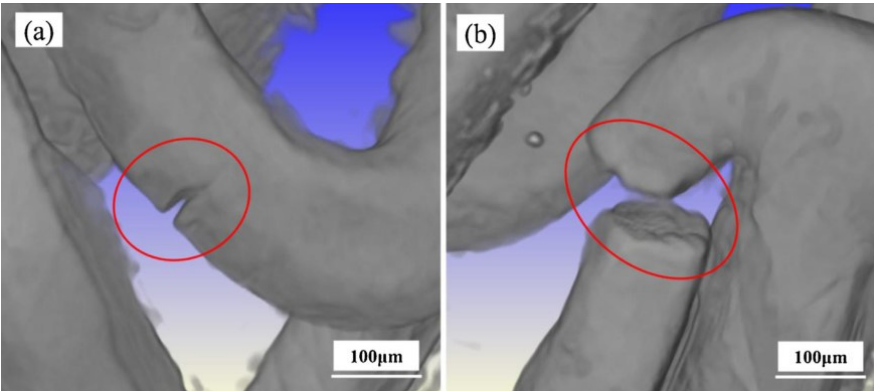
Figure 12. Failure behavior of the L-type AZ31B magnesium alloy coronary artery stent after 1 month ( a ) and 3 months ( b ) implantation. Reproduced with permission from [33], Copyright 2020 Elsevier.